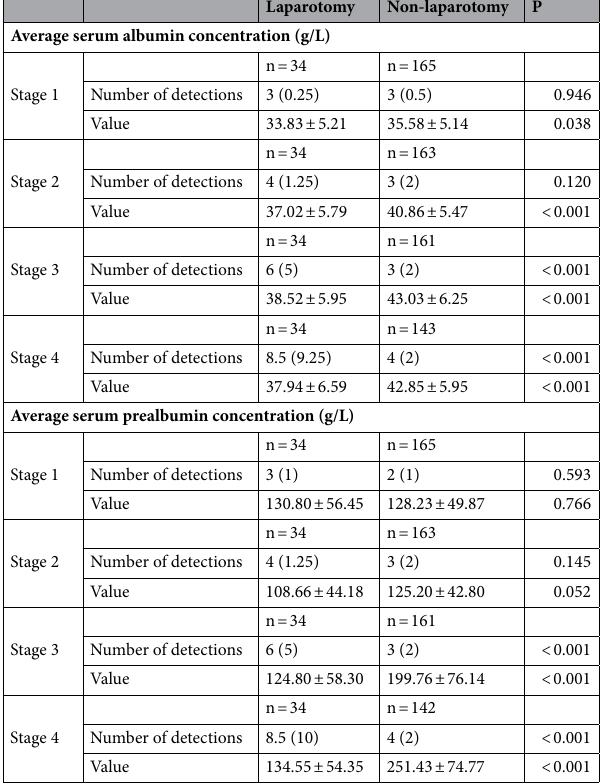
Table 3. Comparison of average serum albumin/prealbumin concentrations between laparotomy and nonlaparotomy patients. Number of detections means the median and interquartile times of albumin/ prealbumin detections in the corresponding stage of every patient.